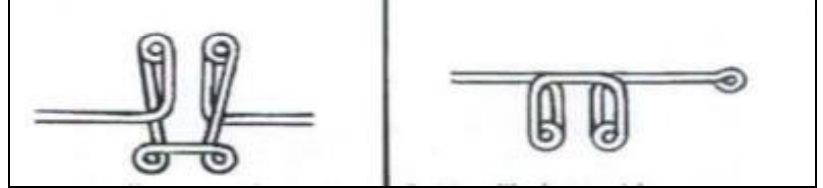
Figure 5: Ricketts cuspid retraction